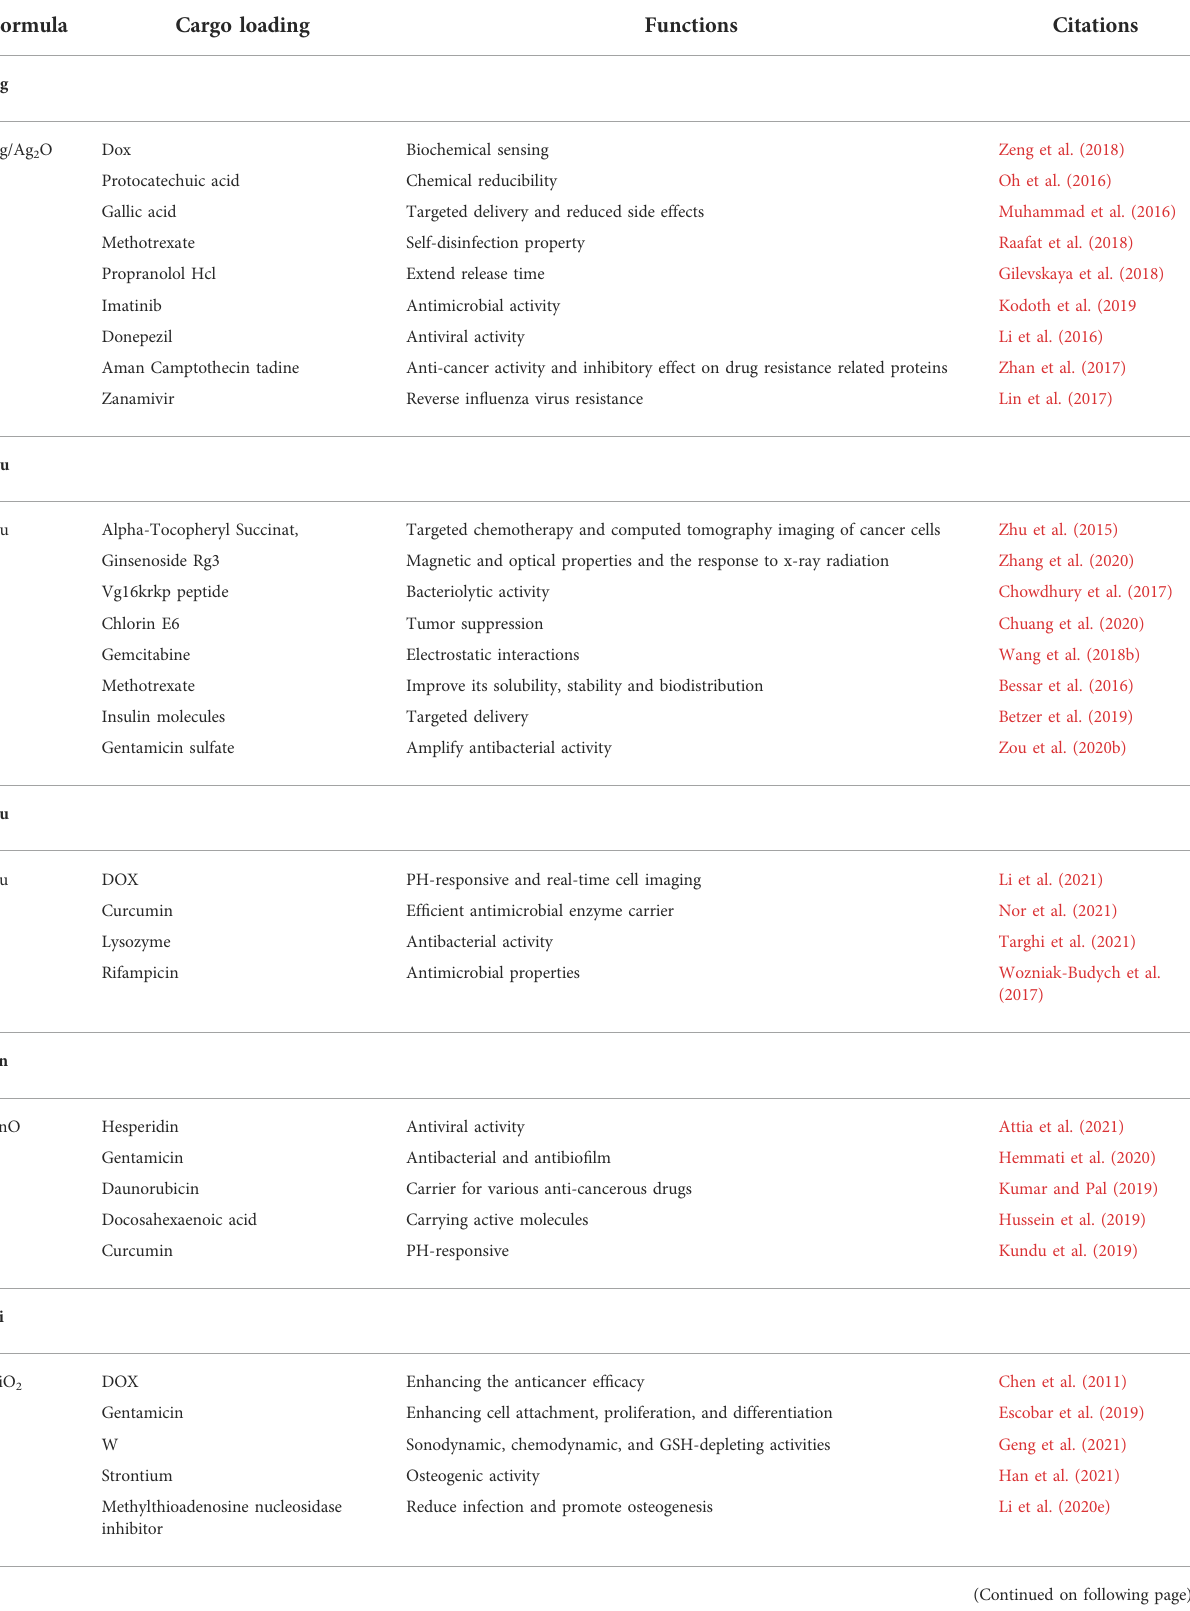
TABLE 1 Classi fi cation of Metallic and Metallic